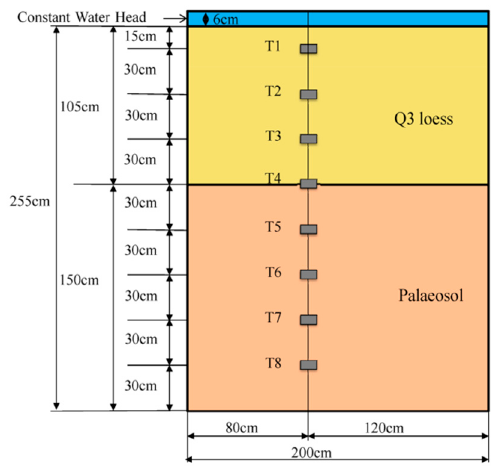
Figure 4. Instruments for the field irrigation experiment.